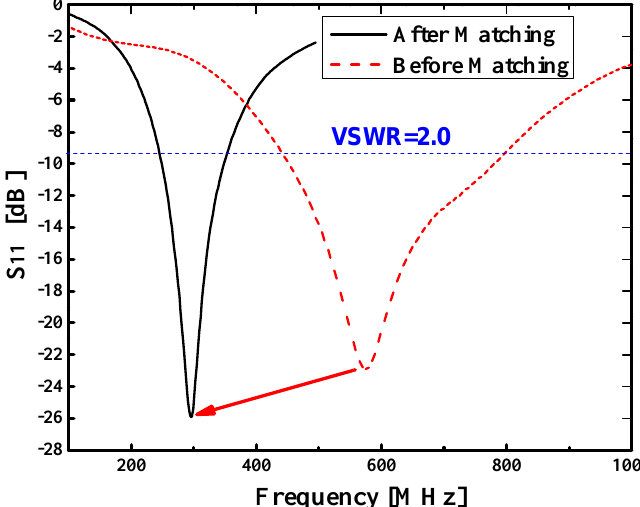
Figure 9. Measured return loss characteristics (S11) of a fabricated antenna on